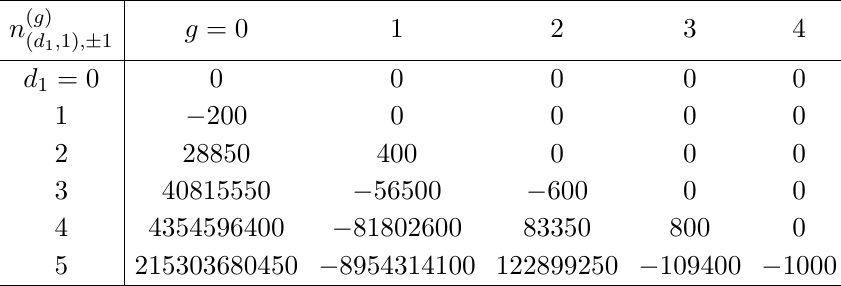
with Z charge ± 1 . 5 0